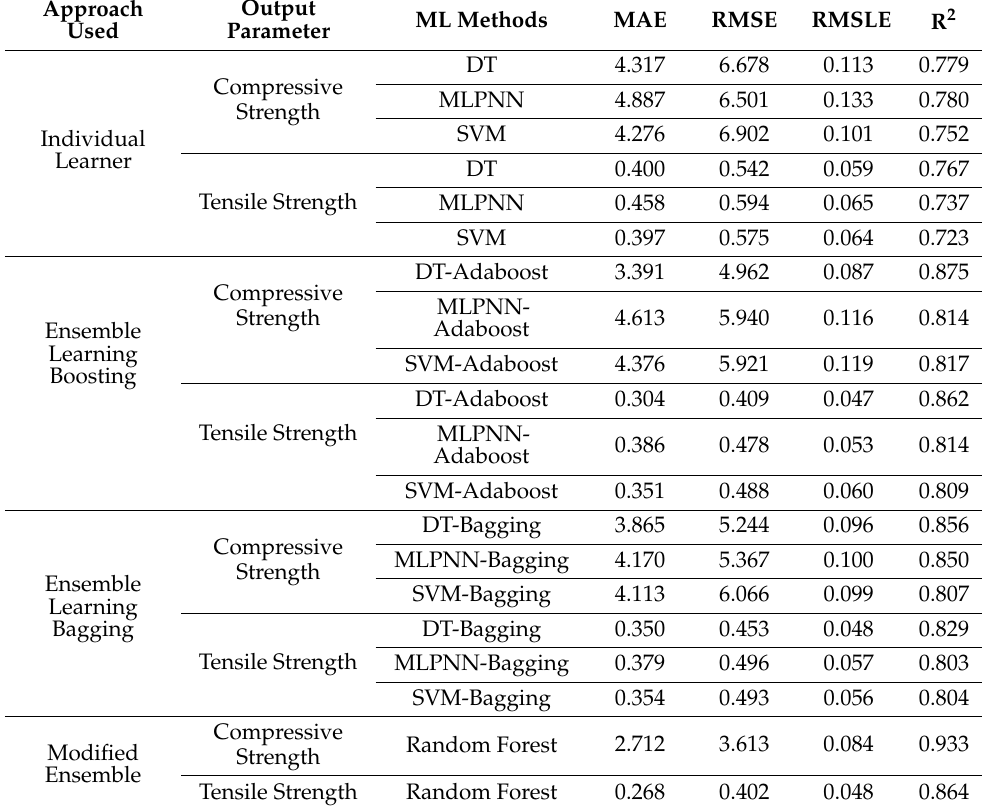
Figure 21. Statistical analysis of tensile strength model. Table 15. Statistical errors for the